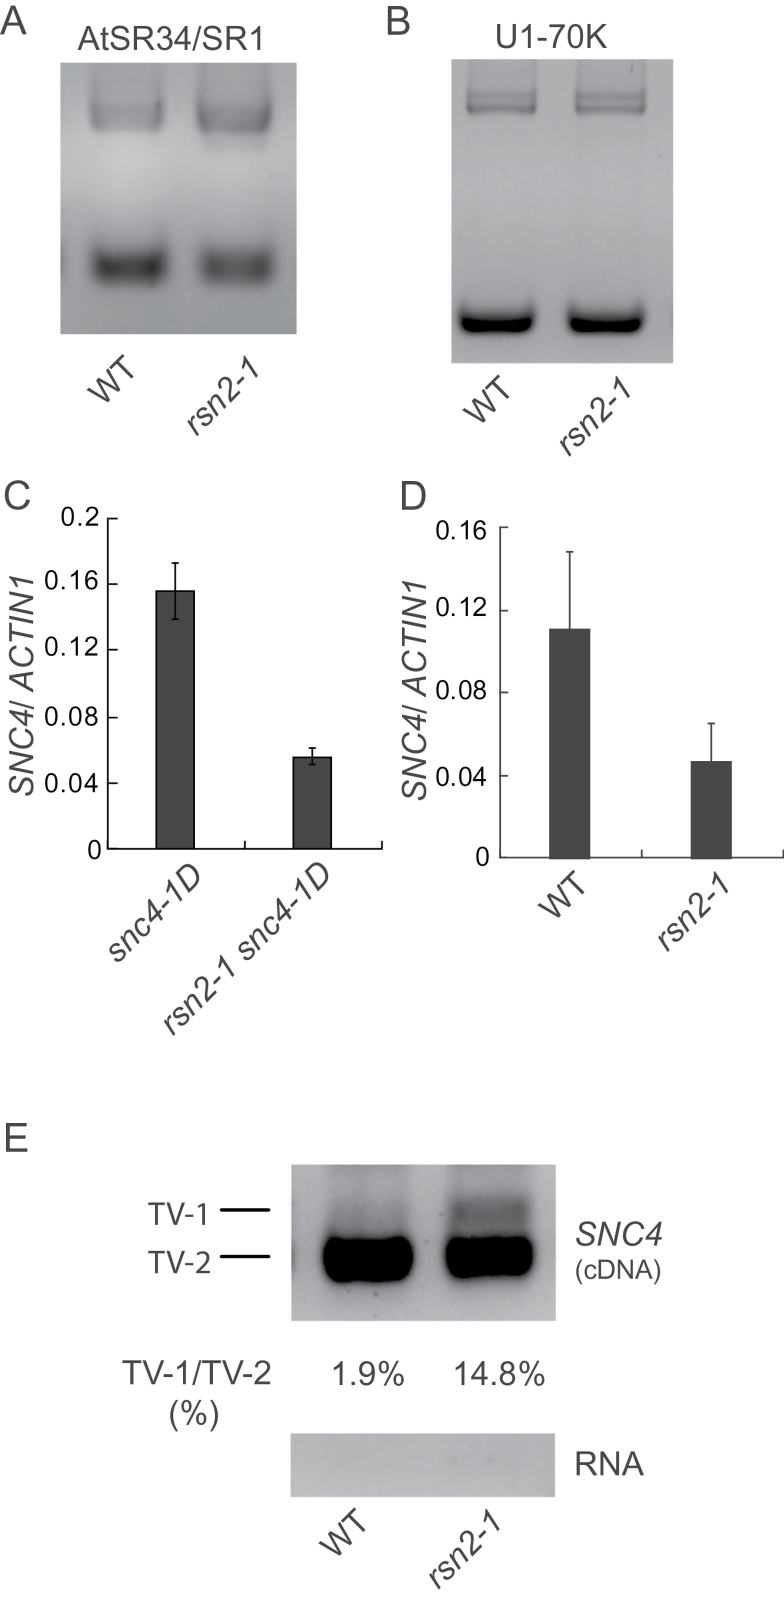

rsn2-1 Exhibits Altered Splicing Pattern and Expression Reduction of SNC4.
(A, B) Alternative splicing patterns of AtSR34/SR1 (A) and U1-70K (B) in wild-type and rsn2-1 plants. The primers used were described previously (Golovkin and Reddy, 1996; Savaldi-Goldstein et al., 2003). Total RNA was extracted from 2-week-old seedlings grown on ½ MS plates and treated with DNase to remove genomic contamination. cDNA was obtained by reverse transcription.
(C, D) Expression level of SNC4 in wild-type and the rsn2-1 single mutant (C) or snc4-1D and the rsn2-1 snc4-1D double mutant (D) detected by real-time PCR. Values were normalized to the expression of ACTIN1. Error bars represent standard deviations of three measurements.
(E) Splicing pattern of SNC4 in WT and rsn2-1 plants. PCR was performed on cDNA or RNA samples using primers SNC4-RT-F and SNC4-RT-R.